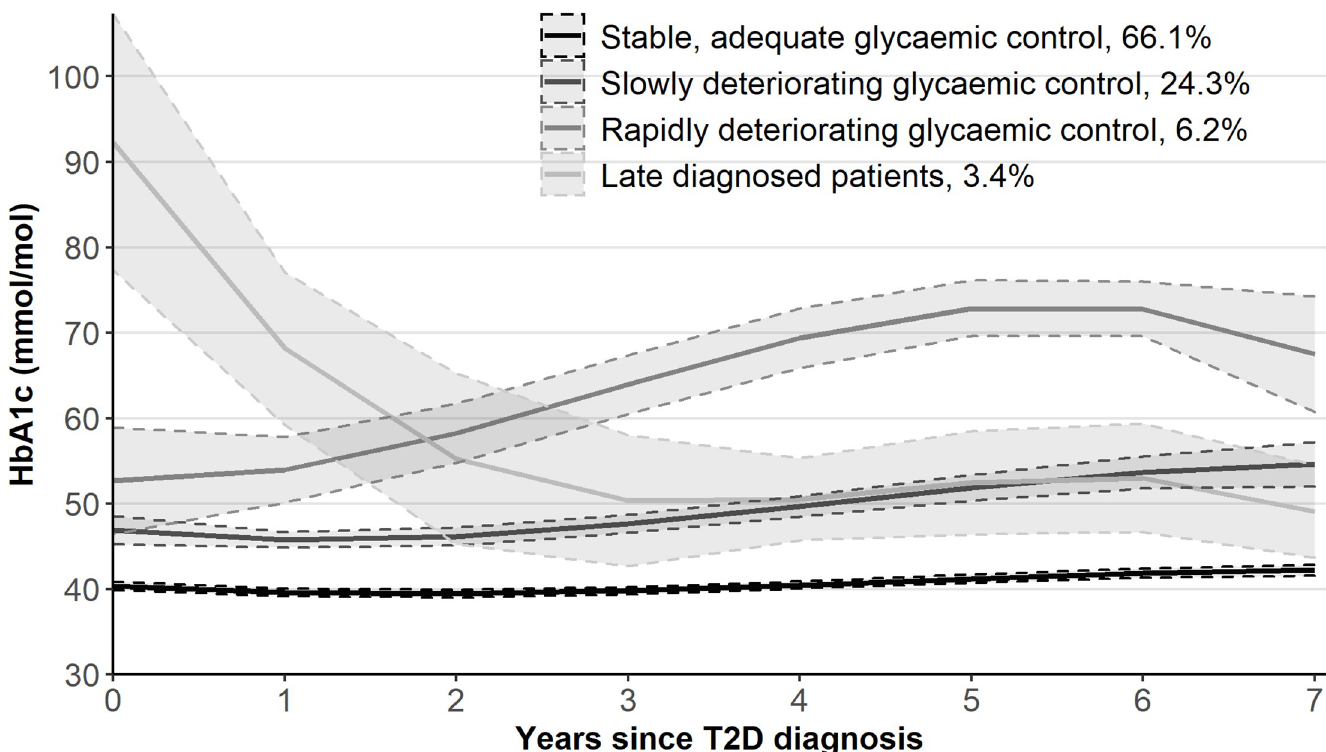
Fig 1. Estimated HbA1c